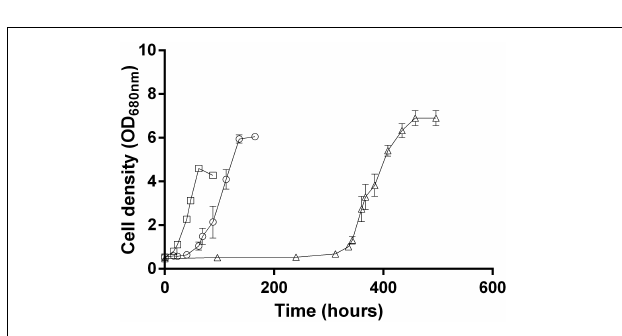
FIGURE 6 | Rhodospirillum rubrum growth in the presence of acetate with 3 mM HCO 3 − supplemented with 10 mM isoleucine ( open triangle ) or with 50 mM of HCO 3 − supplemented ( open circle ) or not ( open square ) with 10 mM isoleucine. N = 5. Results are represented as the mean ±